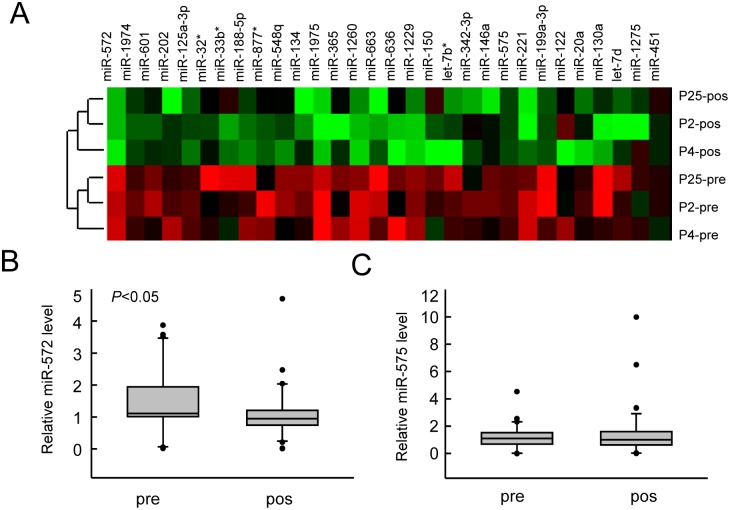
miR-572 levels were decreased in the peripheral blood of POCD patients.A. Microarray results of peripheral blood miRNAs for 3 POCD cases and heat map of cluster analysis for postoperatively downregulated miRNAs. B and C. Changes in the expression of miR-572 and 575 in the peripheral blood of 38 cases of POCD, which were detected using real-time quantitative PCR. pre, preoperation; pos, postoperation.